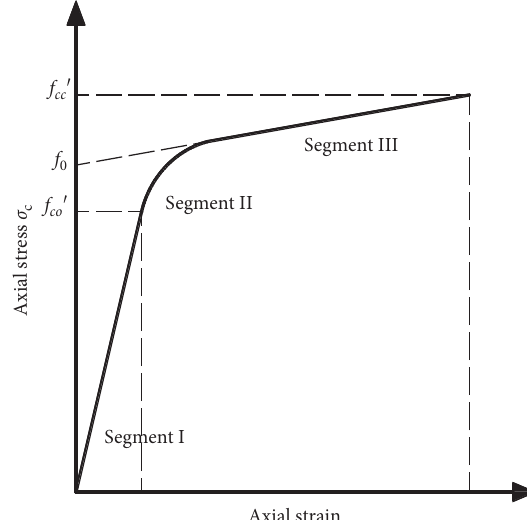
Figure 13: Proposed stress-strain model for